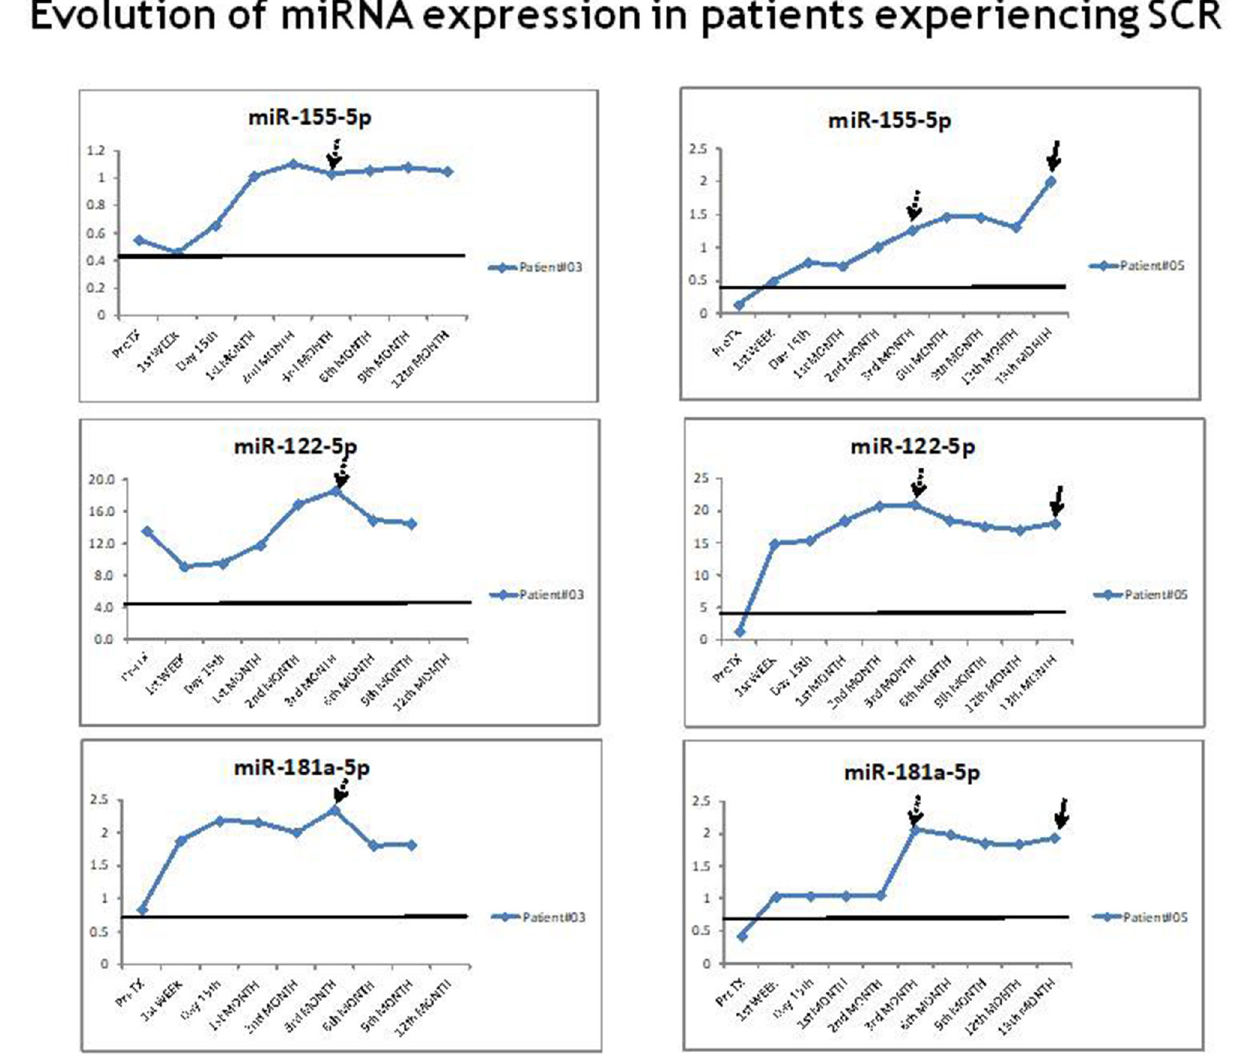
FIGURE 5 | Evolution of miR-155-5p, miR-122-5p, and miR-181a-5p expression in patients experiencing subclinical rejection. An example of the evolution of the miR-155-5p, miR-122-5p, and miR-181a-5p expression in two patients with SCR. The arrow at 3 months post-transplantation indicates the time of the protocol biopsy. In patient #5, the second arrow indicates the time of the TCMAR